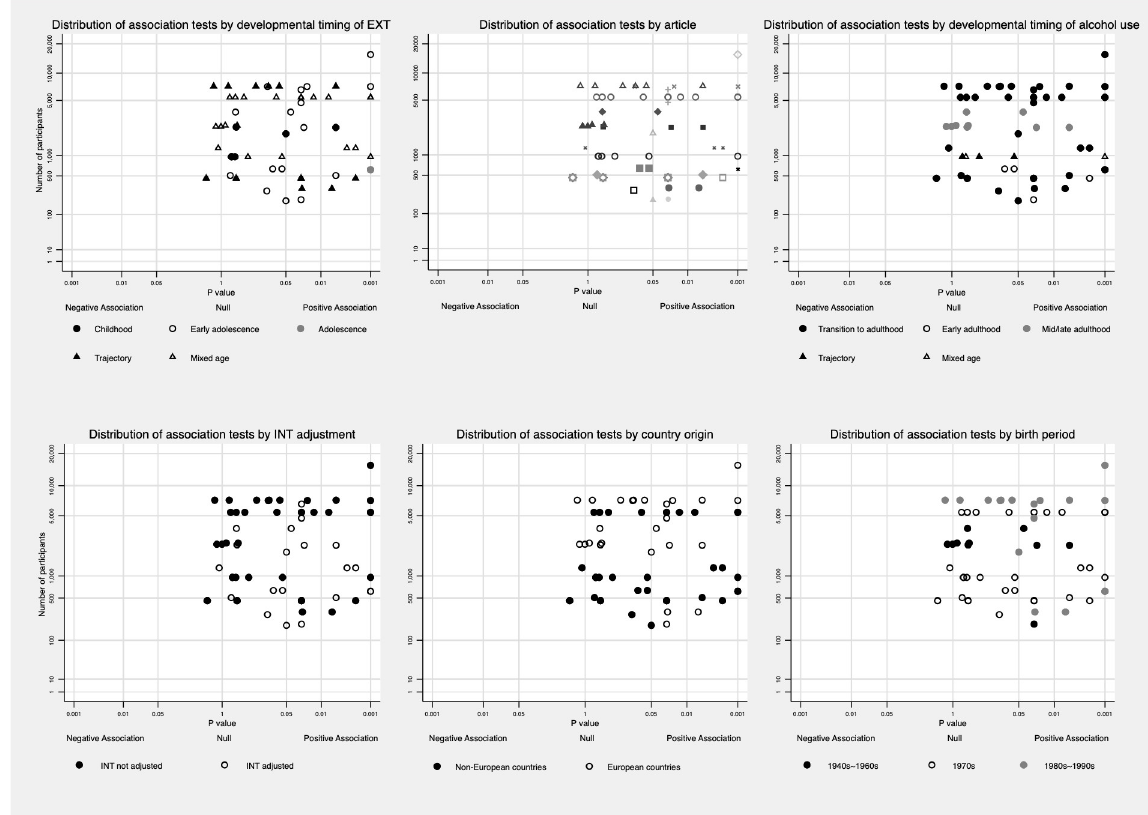
Fig 3. Distribution of association tests between EXT and alcohol problems among various subgroups. Association tests were limited to those using heavy/problematic drinking, AUD as the outcome, and distribution of association tests nested in one article was plotted in the upper middle for easy